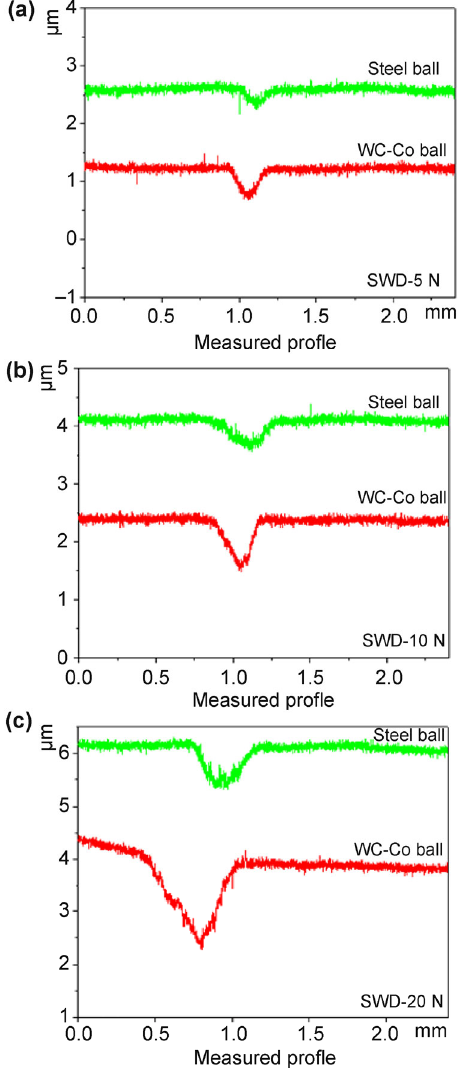
Fig. 5 Typical surface profile of wear scar against WC-Co and steel counterbodies at 20 N for different SiC ceramics sintered with (a) 10, (b) 30 and (c) 50 wt%